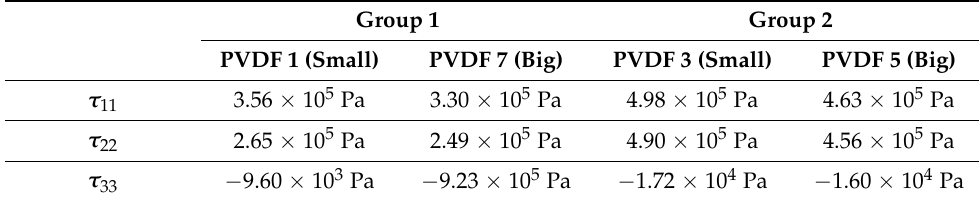
Figure 10. A pair of PVDF elements with different size. Table 3. Averaged volume averaged stresses applied on PVDF elements at 290 Hz.